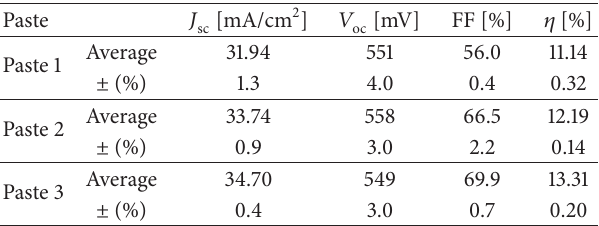
Table 4: Electrical properties of fabricated cells with developed polyvinylalcohol-basedaluminumpastes(averageof3nontextured, w/o ARC